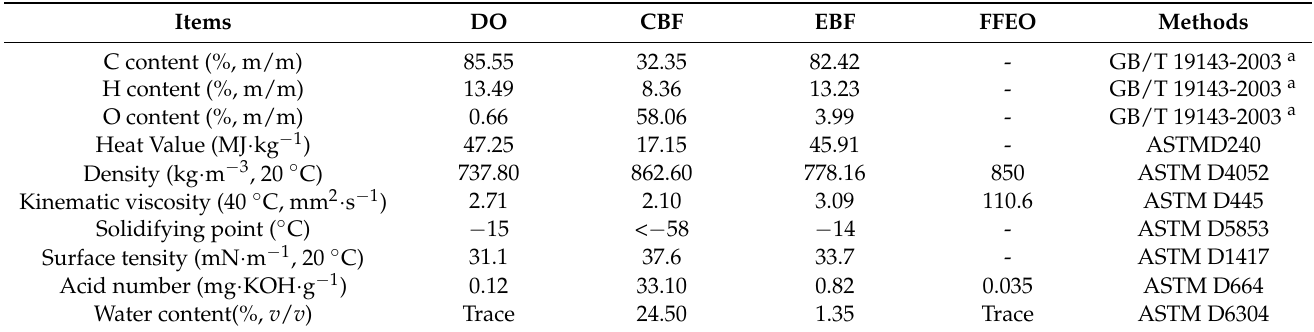
Table 2. The physical and chemical properties of oil